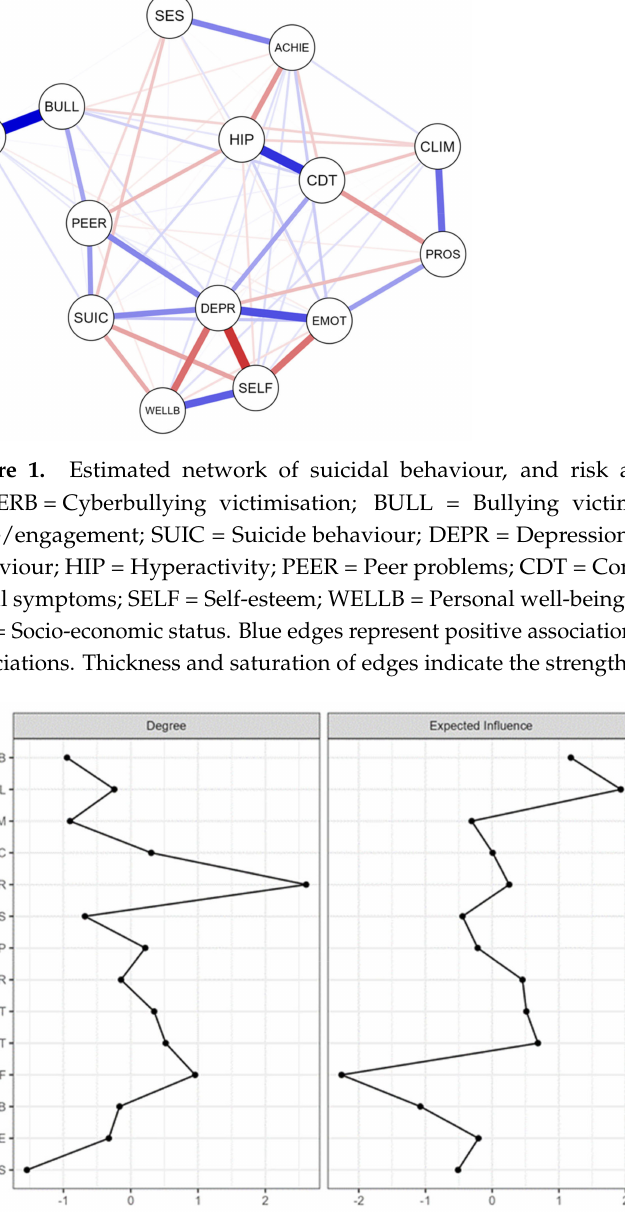
Figure 2. Strength and expected influence values of the suicidal behaviour estimated